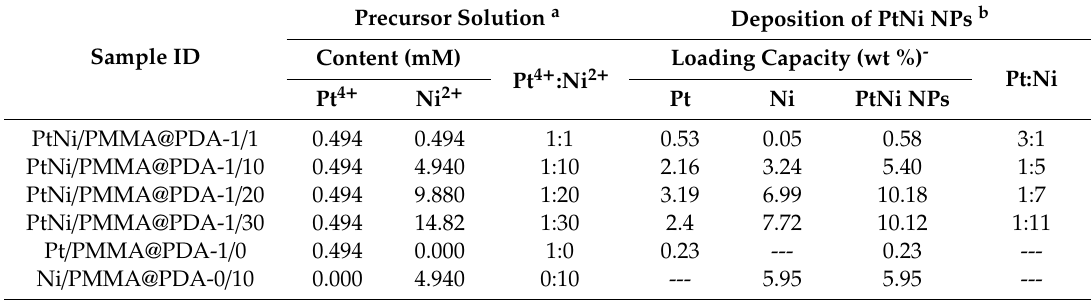
Table 1. Composition of the precursor solution and the deposited PtNi NPs on PMMA@PDA fibers.